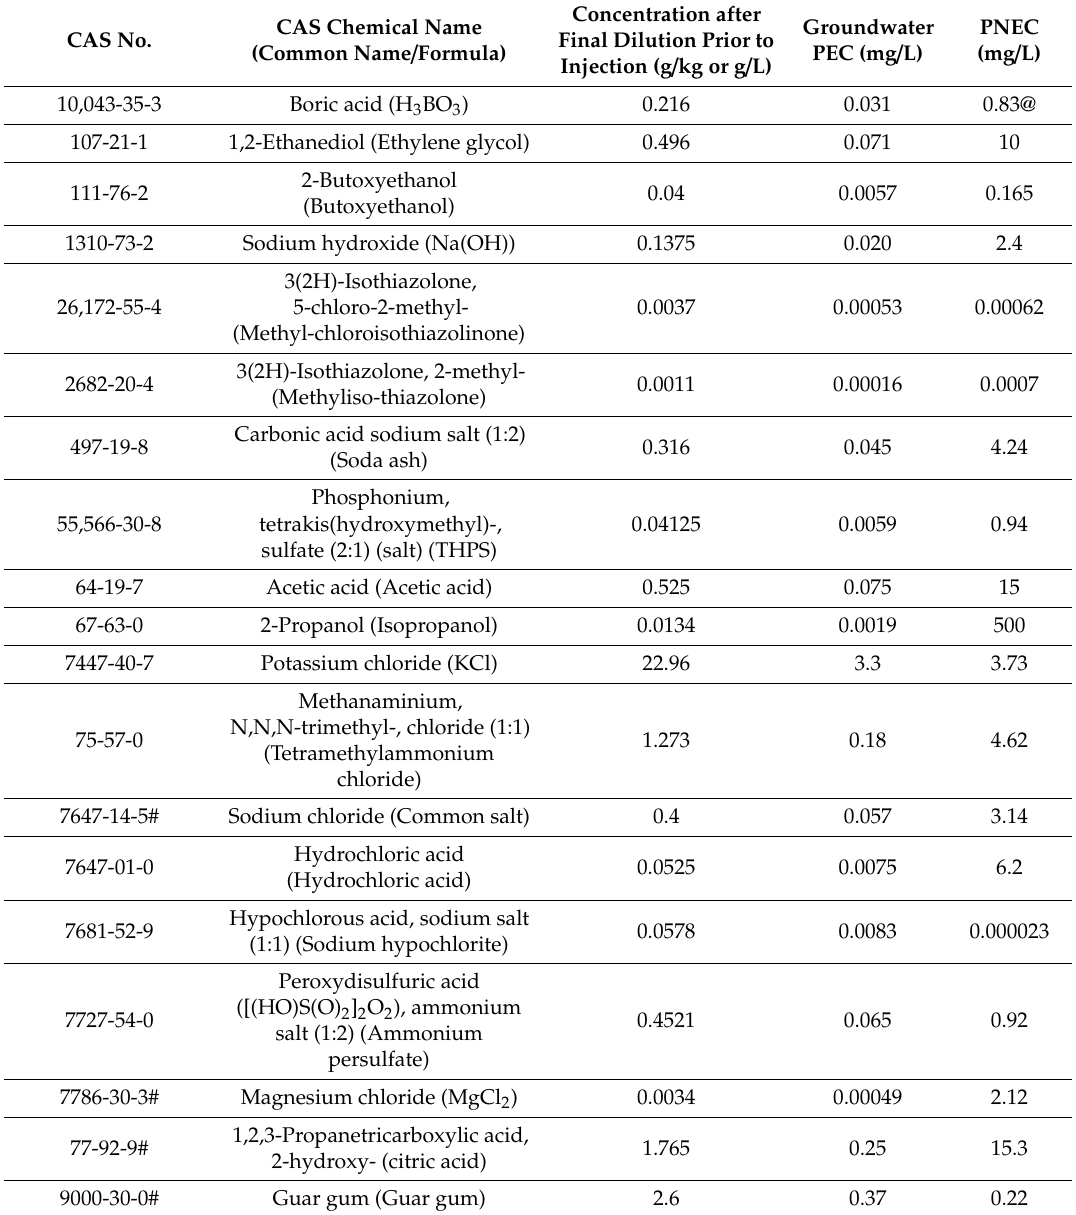
Table 3. Calculated groundwater predicted environmental concentrations (PECs) for chemicals present in hydraulic fracturing products or fracturing pre-treatment formulations (loam soil